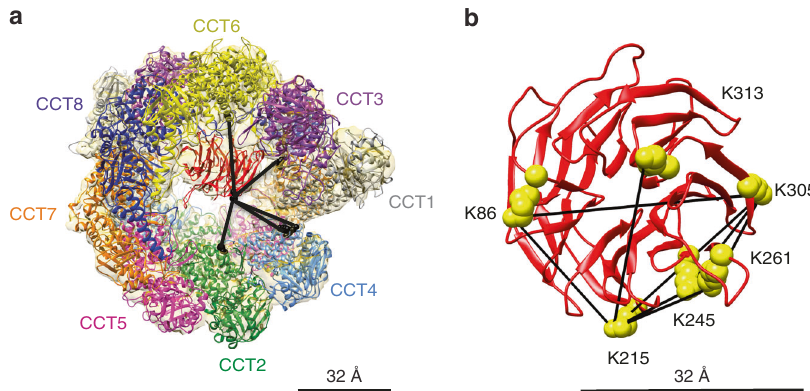
Fig. 5 XL-MS of the mLST8 – CCT complex. a Intermolecular cross-links used to orient mLST8 in the cryo-EM density are mapped onto the mLST8 – CCT structure. The last ordered residue of the termini containing the lysine involved in cross-links are shown as black spheres. b Intramolecular mLST8 cross- links are mapped onto the native structure of mLST8 (PDB 4JT6). The XL-MS pLink output is provided in the Source Data fi